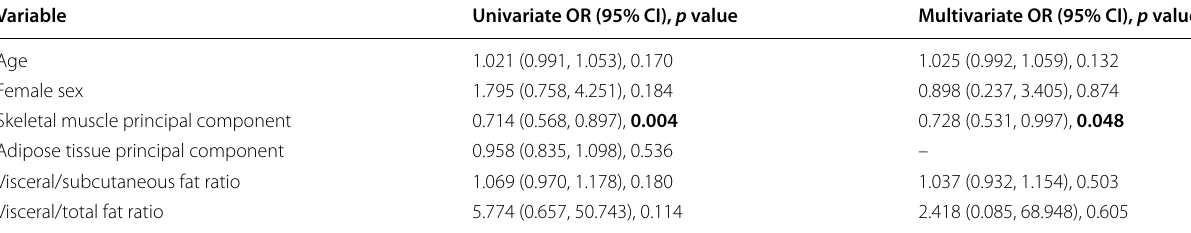
CI confidence interval, OR odds ratio, visceral/subcutaneous fat ratio, area of visceral fat/area of subcutaneous fat, p values lower than 0.05 is presented in bold